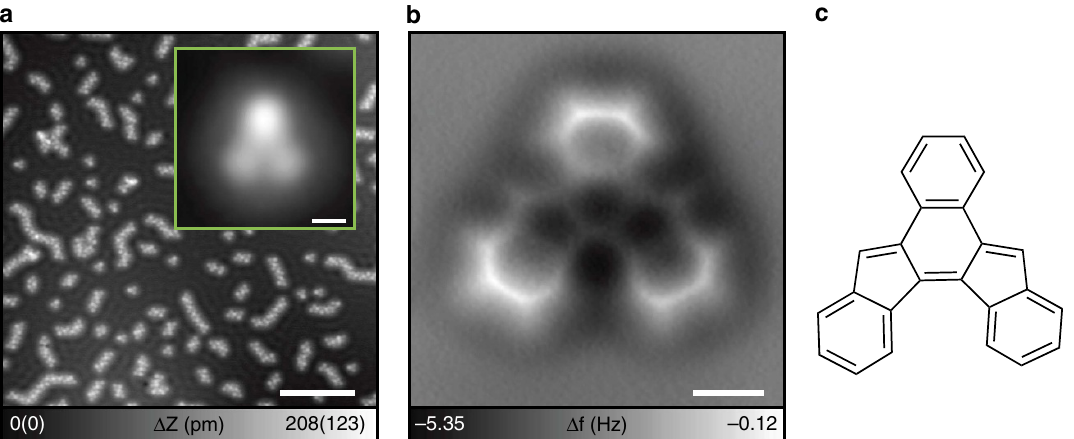
Figure 3 | Second reaction by annealing at 200 (cid:2) C. ( a ) Large-scale STM topography. Inset shows the close view of the individual molecule. Scale bar (inset), 10nm (500pm). ( b ) AFM image of individual transformed tDBA. Scale bar, 300pm. ( c ) Chemical structure of the product. Measurement parameters: V tip ¼ (cid:2) 200mV and I ¼ 1pA in a . V tip ¼ 0mV and A ¼ 60pm in b